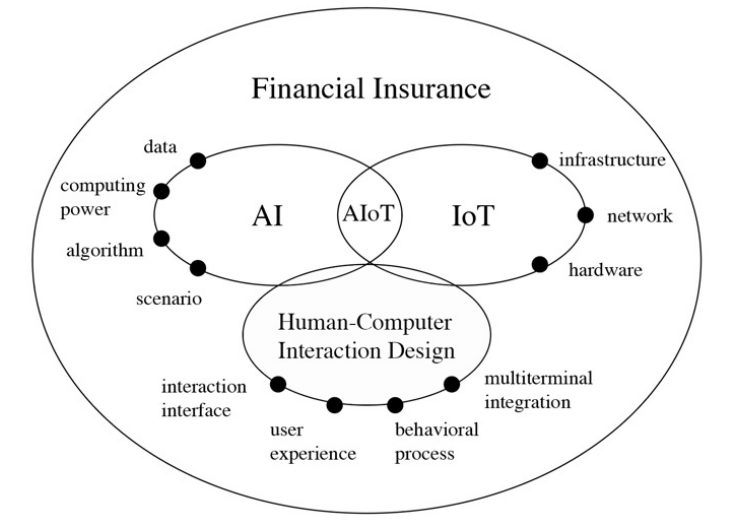
Fig. 1 Framework diagram of the combination of AIoT and human-computer interaction design under the financial and insurance scenario. AI, artificial intelligence; IoT, internet of